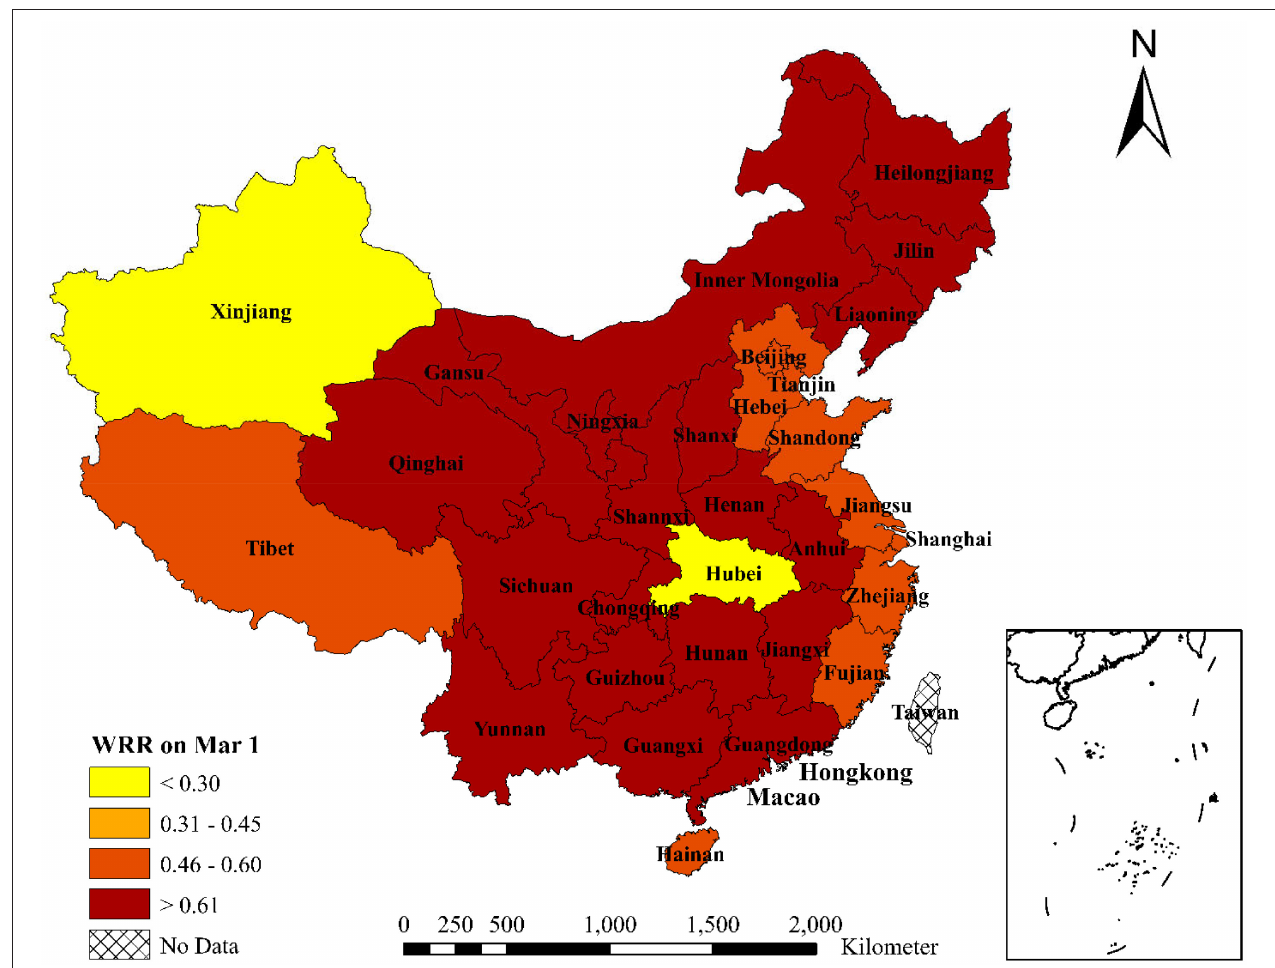
FIGURE 4 | WRR of 31 Chinese provinces on March 1, 2020. This figure shows the work resumption rate (WRR) of 31 provinces in China on March 1, 2020. For WRR on March 1, t 1 is January 25, 2020 and t 2 is March 1, 2020; t ′ 1 is January 10, 2020 and t ′ 2 is January 24,